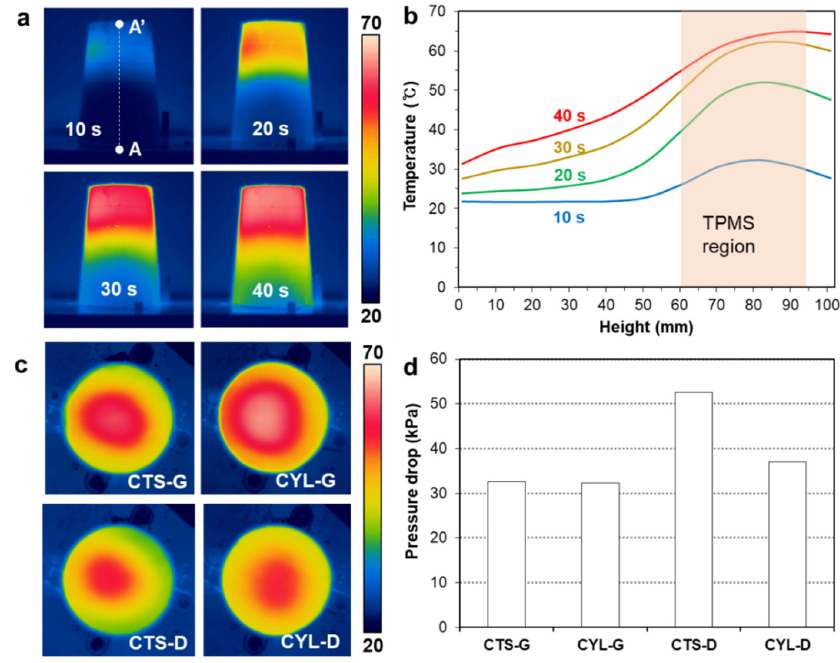
Figure 8. Results of heating experiments for four TPMS structures: ( a ) Change of the side temperature for the CYL-G type TPMS (unit: °C). ( b ) Temperature profiles along path A–A’. ( c ) Temperature distributions of the top surfaces at 20 s heating (unit: °C). ( d ) Comparison of pressure drops. To quantitatively investigate the temperature uniformity in the target region, tem- perature changes at P 1 and P 2 on the top surface, marked in Figure 4d, are plotted in Figure 9a,b, respectively. The corresponding temperature differences between P 1 and P 2 are plot- ted in Figure 9c, which shows that TPMSs based on the cylindrical coordinate provide more uniform temperature distributions than TPMSs based on the Cartesian coordinate. Figure 9. Temperature changes on the top surfaces for various TPMS shapes: ( a ) at Point 1 (P 1 ); ( b ) at Point 2 (P 2 ). ( c ) Temperature difference between P 1 and P 2 . To quantitatively investigate the heating capability, the temperature changes at P 3 and P 4 on the side surface, marked in Figure 4e, are plotted in Figure 10a,b, respectively.